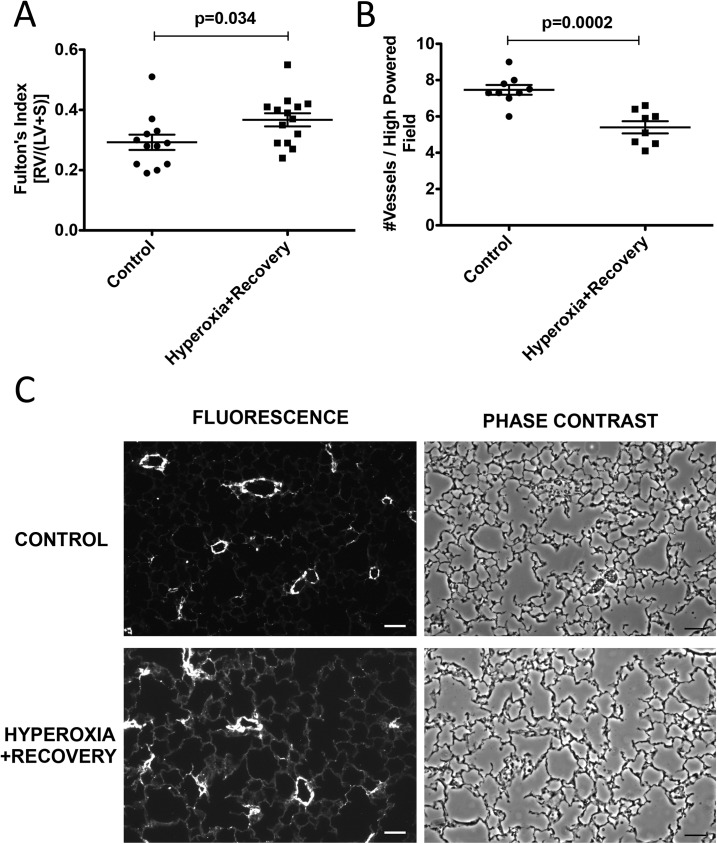
Mice exposed to neonatal hyperoxia have persistent RVH and decreased vessel density at 21d.Mice were exposed to hyperoxia or room air for 14d, followed by recovery in room air for an additional 7d (21d). (A) Fulton’s index (RV weight/LV+S weight) was used to assess RVH (n = 12–14 animals per group). (B) vWF staining was performed on lung sections to evaluate vessel number. Small non-muscularized PAs (<100 μM) were counted and averaged per animal (n = 8–9 animals per group). (C) Representative phase and fluorescent images are shown for 21d control and 21d hyperoxia + recovery. Bar = 50 μm. Data are expressed as dot plots with each dot representing individual animals with means and SEM represented by horizontal lines. Results were analyzed using an unpaired t-test.